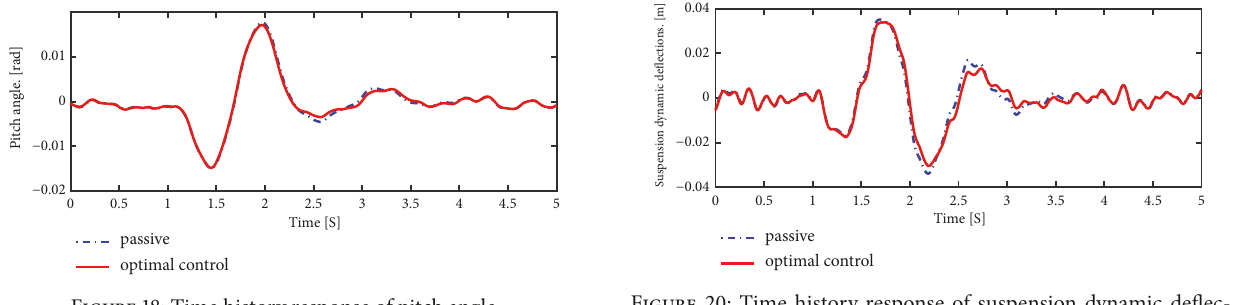
Figure 18: Time history response of pitch angle.